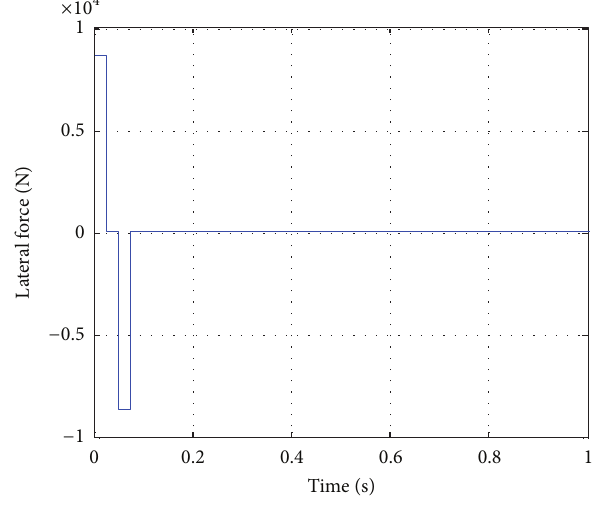
Figure 9: The response of lateral force.